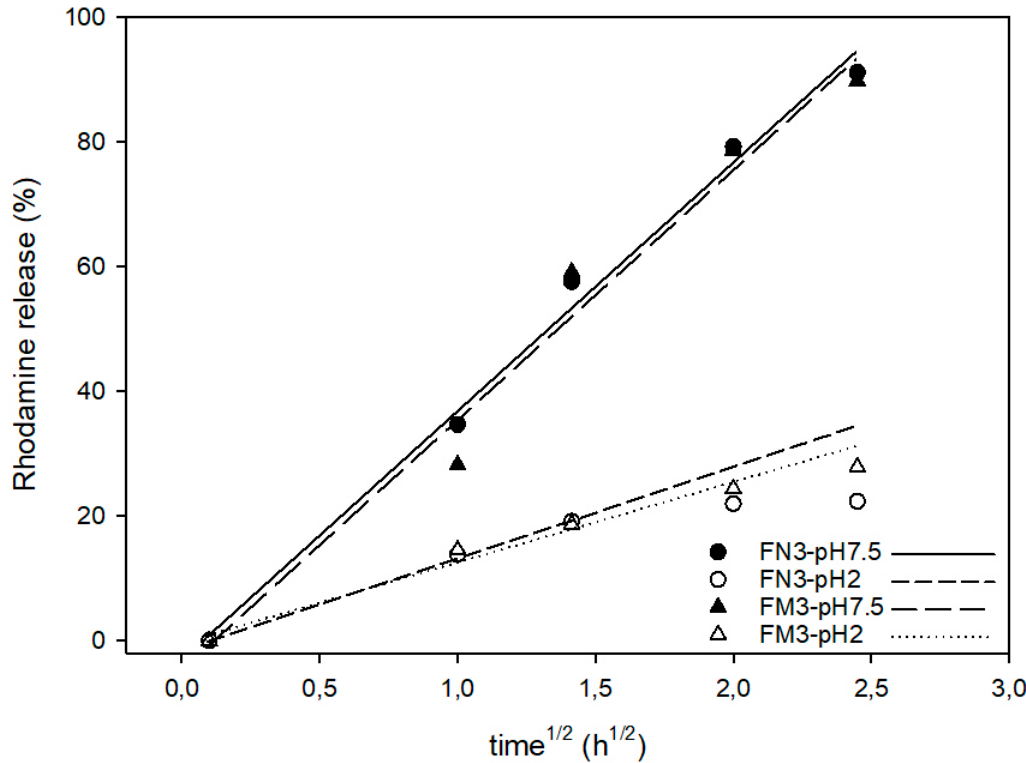
Figure 8. Higuchi representation of rhodamine B release from EVOH 32-M-Rh-N3 and EVOH 32-N-Rh-N3 prepared at pH 3 in aqueous media at acidic pH (pH = 2) and at neutral pH (pH = 7.5). Symbols correspond to experimental data, and the lines are the fitting lines of the Higuchi equation.